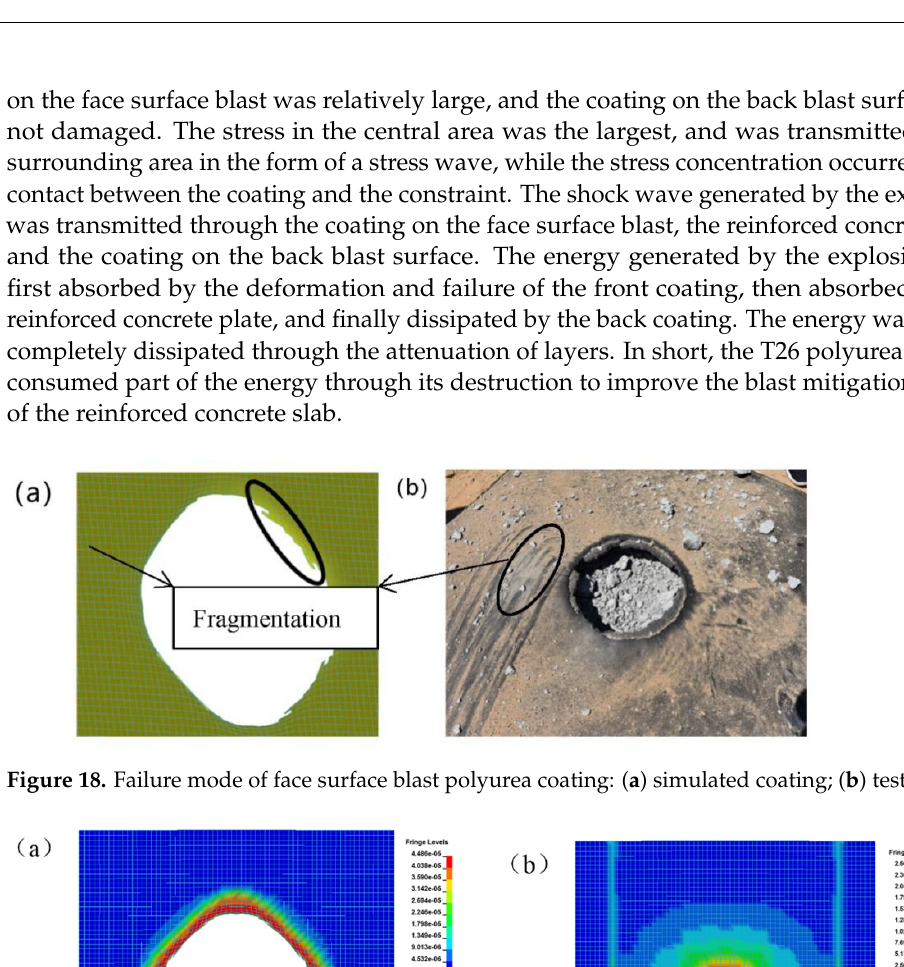
15 of 19 Figure 17. Stress nephograms of coated reinforced concrete slab at time t = 1000 μ s: ( a ) face surface blast; ( b ) back blast surface; ( c ) side face. In summary, a T26 polyurea coating can improve the blast mitigation ability of rein- forced concrete slabs, which played a key role in the blast mitigation protection of rein- forced concrete slabs. The numerical simulation and explosion test damage diagram of T26 polyurea are shown in Figure 18a,b. The central area of the coating was damaged by perforation, and the damaged area was approximately circular. The cross-section of the coating protruded upward around the extended circular area, and the destruction of the circular edge was not smooth, showing debris. The coating failure included tearing and tensile failure and mainly tearing failure, as shown in Figure 18a,b. The above thermal